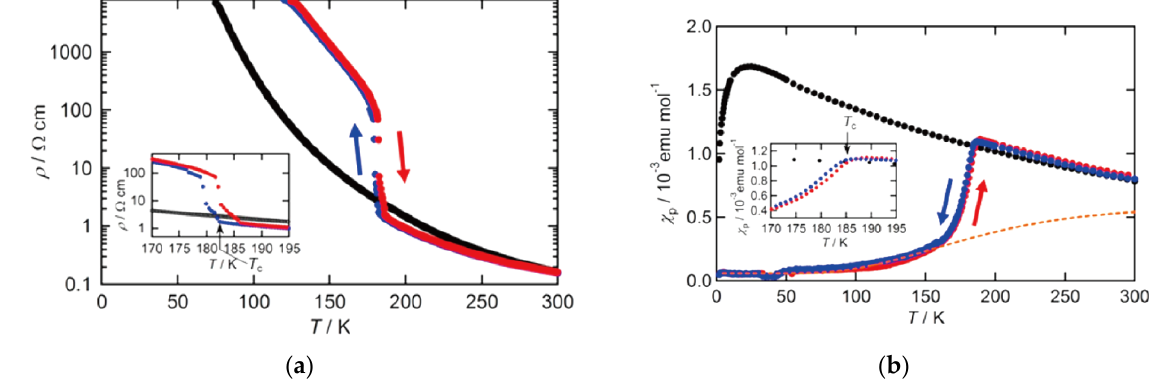
Figure 7. Temperature dependence of the physical properties of κ -H 3 (Cat-EDT-TTF) 2 ( κ -H) and κ -D 3 (Cat-EDT-TTF) 2 ( κ -D): ( a ) electrical resistivity measured using a single crystal; ( b ) magnetic susceptibility measured using a polycrystalline sample. In both figures, the blue and red circles denote the data observed in the cooling and heating processes, respectively, for κ -D, while the black circles denote the data for κ -H observed in the cooling processes. The orange broken curve in ( b ) represents the best fitting curve for the κ -D data using a singlet–triplet dimer model with an antiferromagnetic coupling of 2 J / k B ~ 600 K. Adapted from Ref. [771] with −